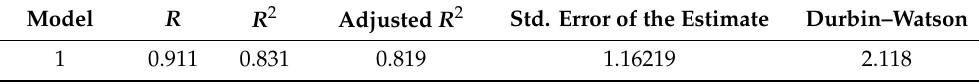
Table 3. Model summary utilizing the enter